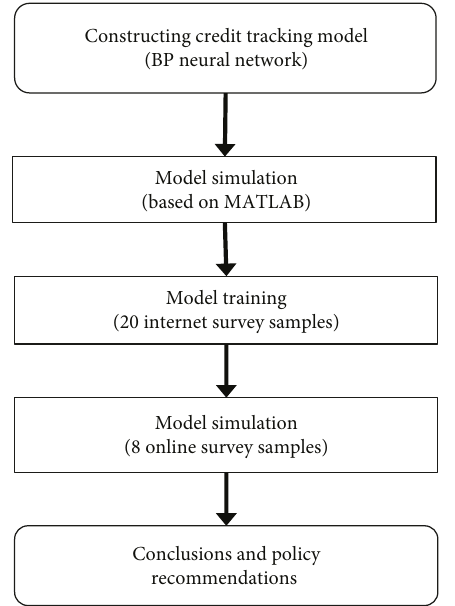
Figure 5: Construction and application fl owchart of dynamic credit tracking rating